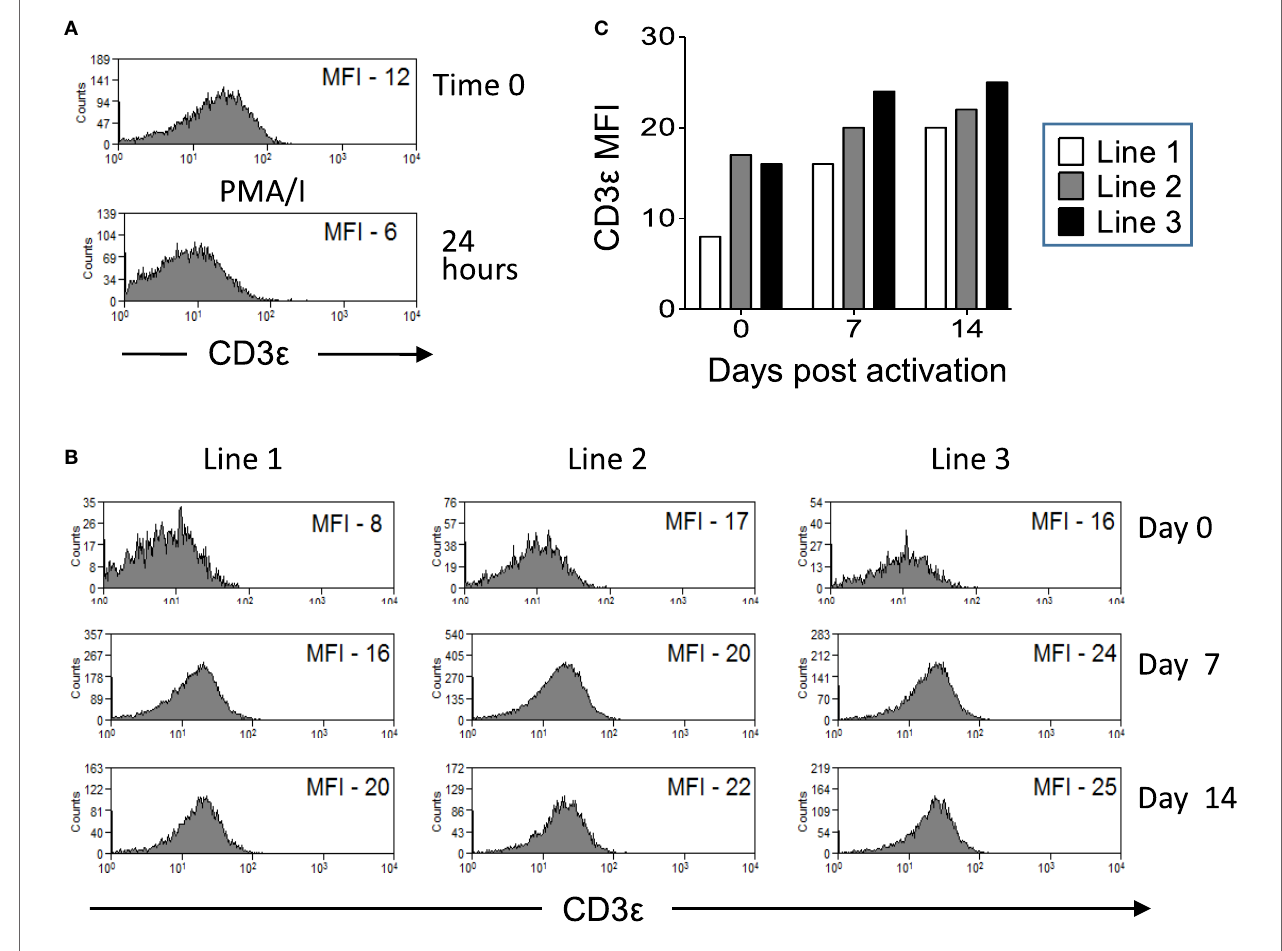
FigUre 5 | CD3 ε expression by V δ 1 T cells is modulated over time post activation. CD3 ε hi and CD3 ε lo V δ 1 T cells were sorted from lines of expanded V δ 1 T cells from three donors. Cells were restimulated with phorbol myristate acetate with ionomycin (PMA/I) or heat-killed Candida albicans presented by monocyte-derived dendritic cell and PHA and cultured in the presence of interleukin (IL)-2. The expression of CD3 ε by gated V δ 1 T cells was examined at times 0, 1, 7, and 14 days by flow cytometry. (a) Flow cytometry histograms showing downregulation of CD3 ε by sorted CD3 ε hi V δ 1 T cells stimulated for 24 h with PMA/I. (B) Flow cytometry histograms showing the upregulation of CD3 ε expression by sorted CD3 ε lo V δ 1 T cells after stimulation with C. albicans and culture with IL-2. (c) Mean fluorescence intensities (MFIs) of CD3 ε expression by V δ 1 T cells from three donors over time after C. albicans